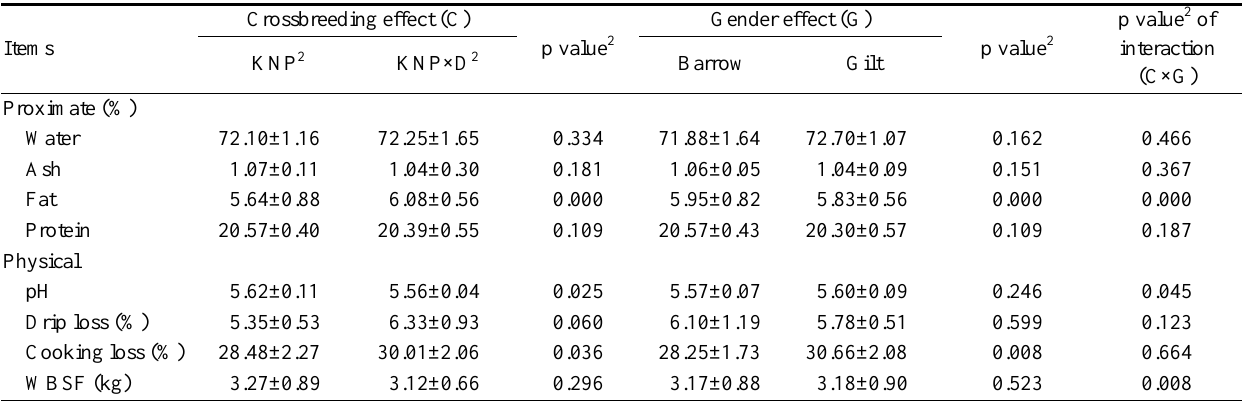
Table 2. Proximate and physical qualites 1 of Musculus longissimus dorsi of Korean Native Black Pig and its crossbred with Duroc pig Items